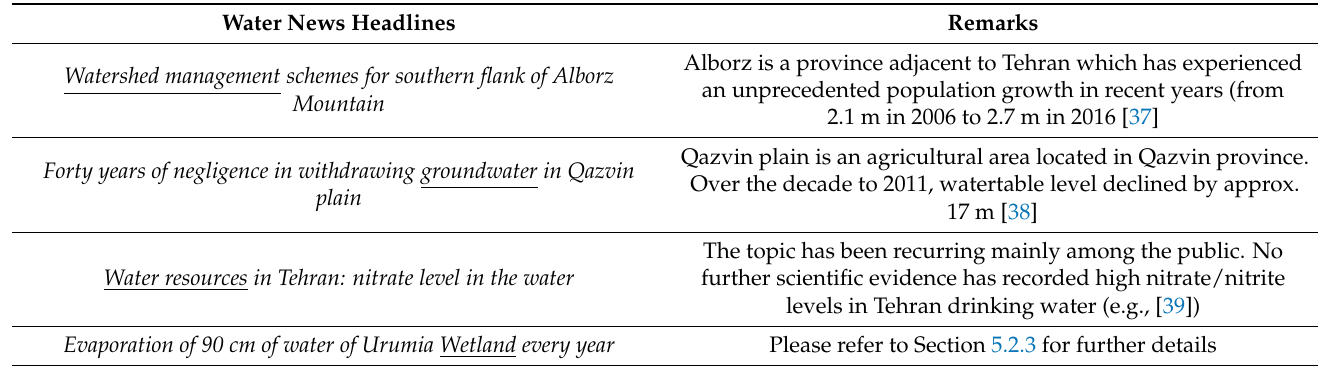
Table 2. Examples of water news headlines in Iranian newspapers ( Translated to English ).